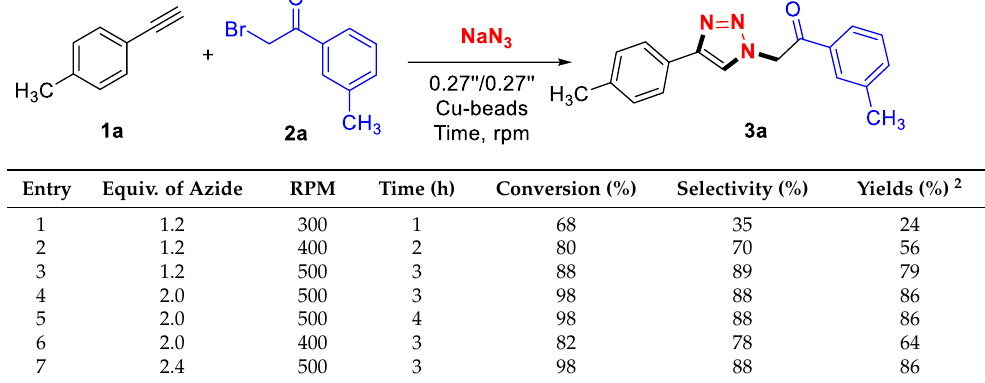
Table 1. Mechanochemical optimization of reaction parameters 1 .